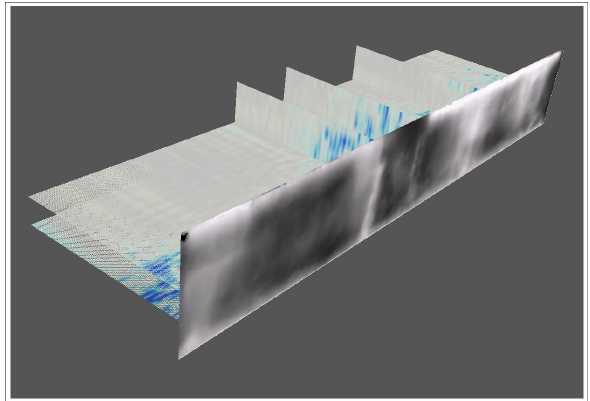
Figure 8. Registering of a thermal orthophoto-mosaic and GPR slices with CloudCompare (riverside façade).